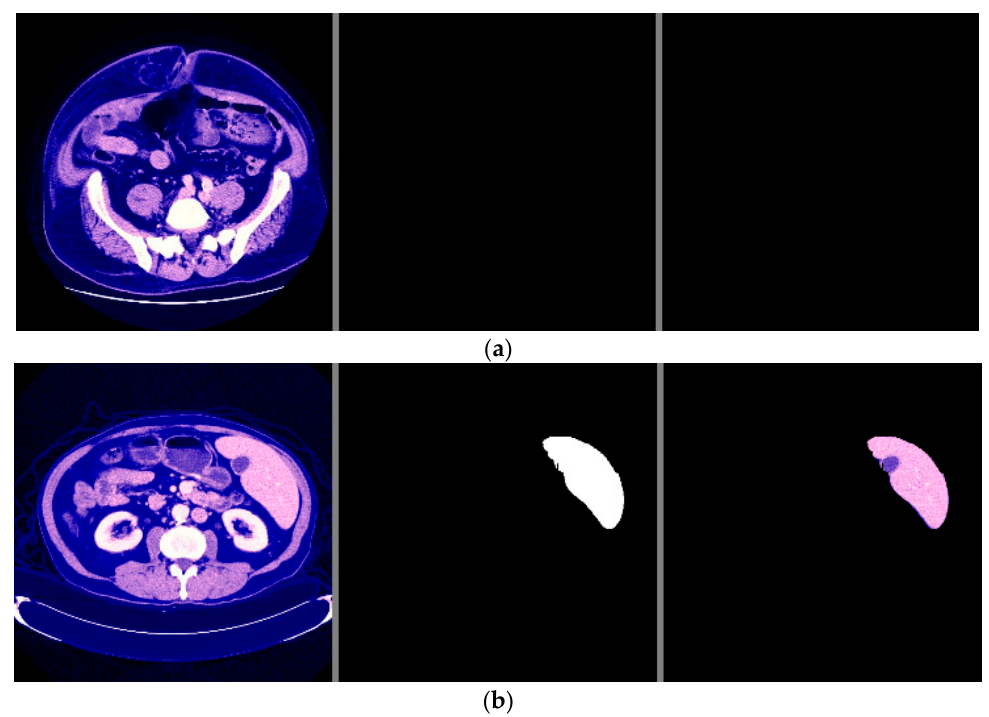
dataset are shown in Figure 7.